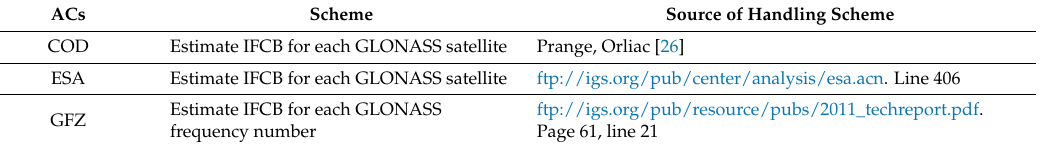
Table 1. Global Navigation Satellite System (GLONASS) inter-frequency code bias (IFCB) handling schemes of three International GNSS Service (IGS) analysis centers (ACs) in GLONASS satellite clock offset